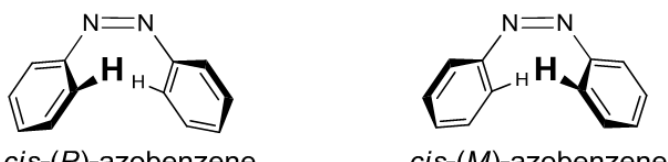
Figure 2. Helicity of the cis